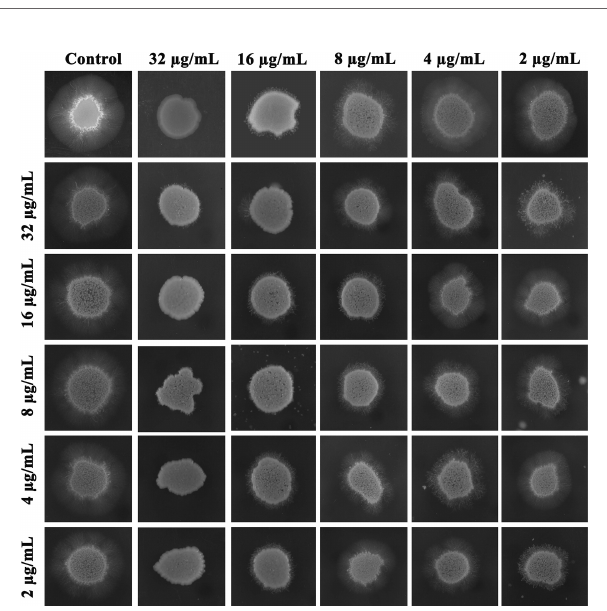
FIGURE 6 | Antihyphal activity of individual and combination of piperine and thymol. Supplementation of FBS, a fi lament-inducing component, resulted in increased hyphal elongation around the cell surface of untreated C. albicans , whereas piperine at MBIC resulted in complete inhibition of hyphal form. Thymol at MBIC slightly inhibited the fi lamentation. At the 8 + 8-µg/ml concentration, synergistic antihyphal activity was observed with a FICI of